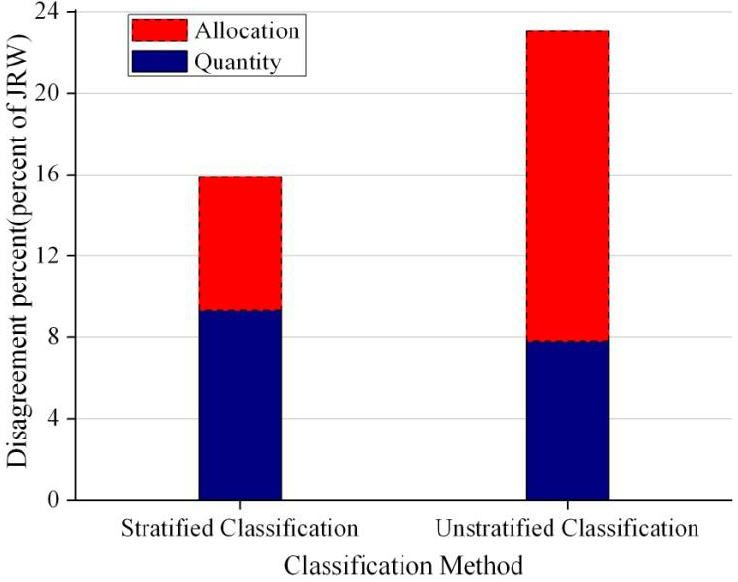
Figure 4. Components of disagreement between LULC maps of 2002 and the reference